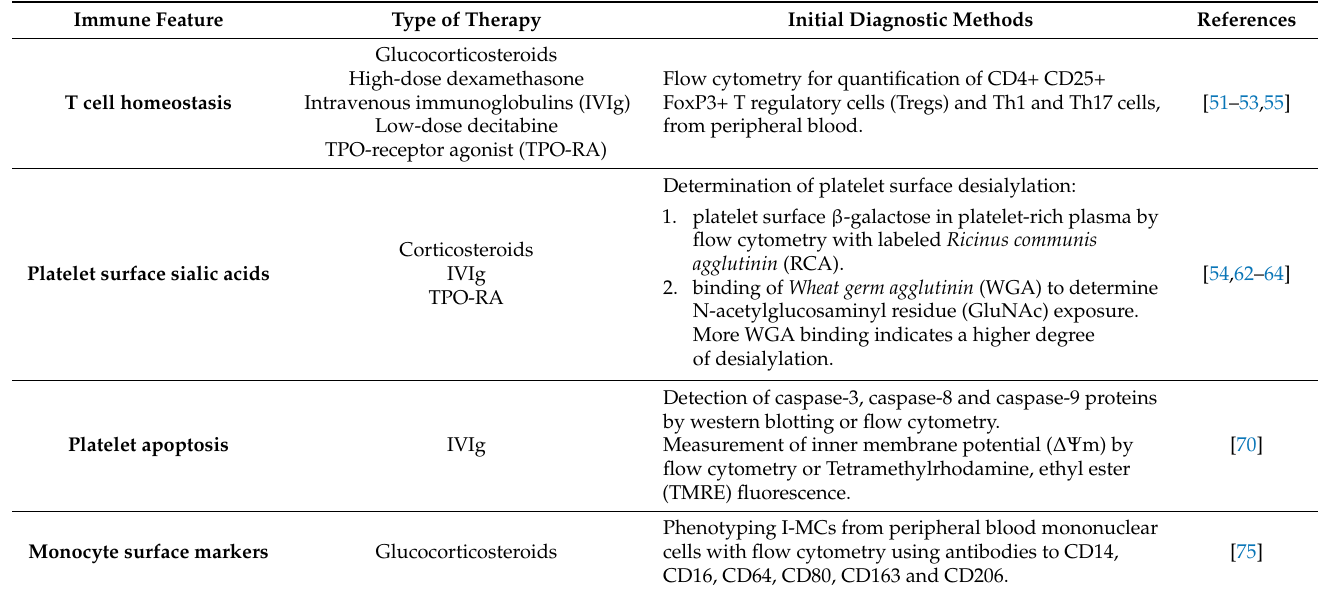
Figure 1. Potential diagnostic approaches for assessment of therapeutic responses in ITP. Promising diagnostic approaches for prediction of platelet count responses and thereby distinguish therapeutic responders from non-responders are depicted: T cell homeostasis (D1), Platelet surface sialic acids (D2), Platelet apoptosis (D3), Monocyte surface markers (D4), B regulatory cells (D5) and Platelet microparticles (PMPs). Each approach indicates therapeutic non-response vs. response, with their effects (+ indicates a stimulatory effect and - an inhibitory effect) on the features of the ITP pathophysiology. So far, the initial preliminary evidence may support the involvement of the following therapeutic modalities in relation to the diagnostic approaches: (D1) glucocorticosteroids, high-dose dexamethasone, IVIg, low-dose decitabine, TPO-RA; (D2) Corticosteroids, IVIg, TPO-RA; (D3) IVIg; (D4) glucocorticosteroids; (D5) TPO-RA; (D6) Corticosteroids, TPO-RA. This figure was created with BioRender.com. Table 1. Immune features and potential initial diagnostic evaluations for monitoring and predicting therapeutic responses in